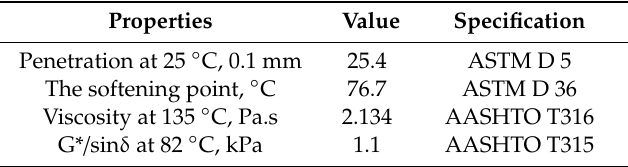
Table 3. Properties of recovered reclaimed asphalt